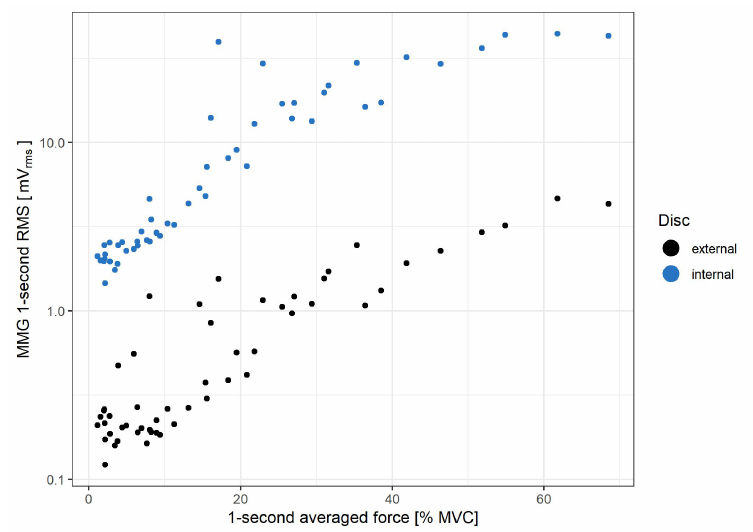
Figure 10. MMG as function of force exerted by the muscle during the ramp (from 0% to 70% MVC in 50 s) isometric contraction. Data are plotted both for internal (blue) and external (black) piezoelectric